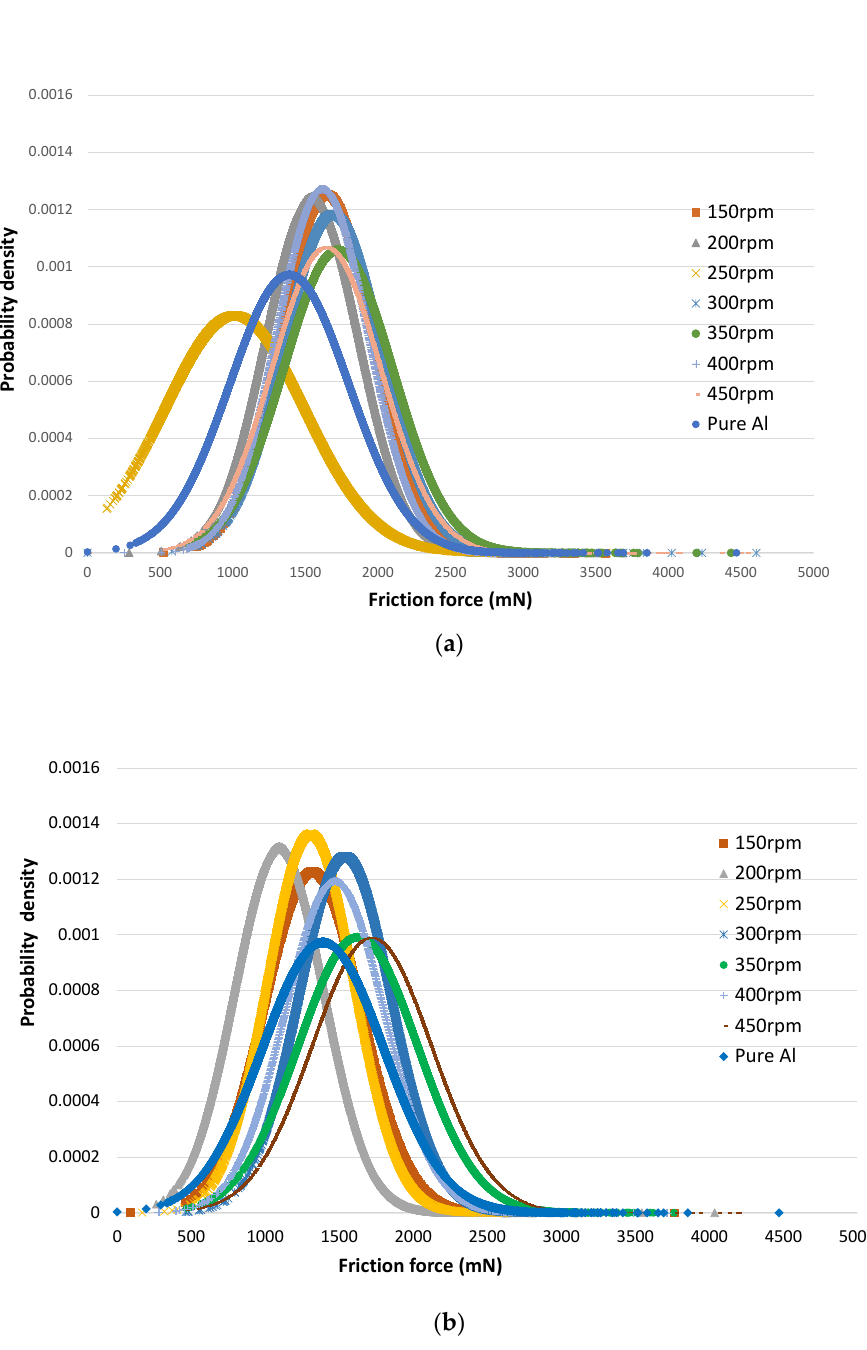
Figure 10. Probability density against friction force on ( a ) CNT-rich surface and ( b ) CNT-poor Scheme 150. to 450 rpm. (As a reference, pure Al data are also shown.).